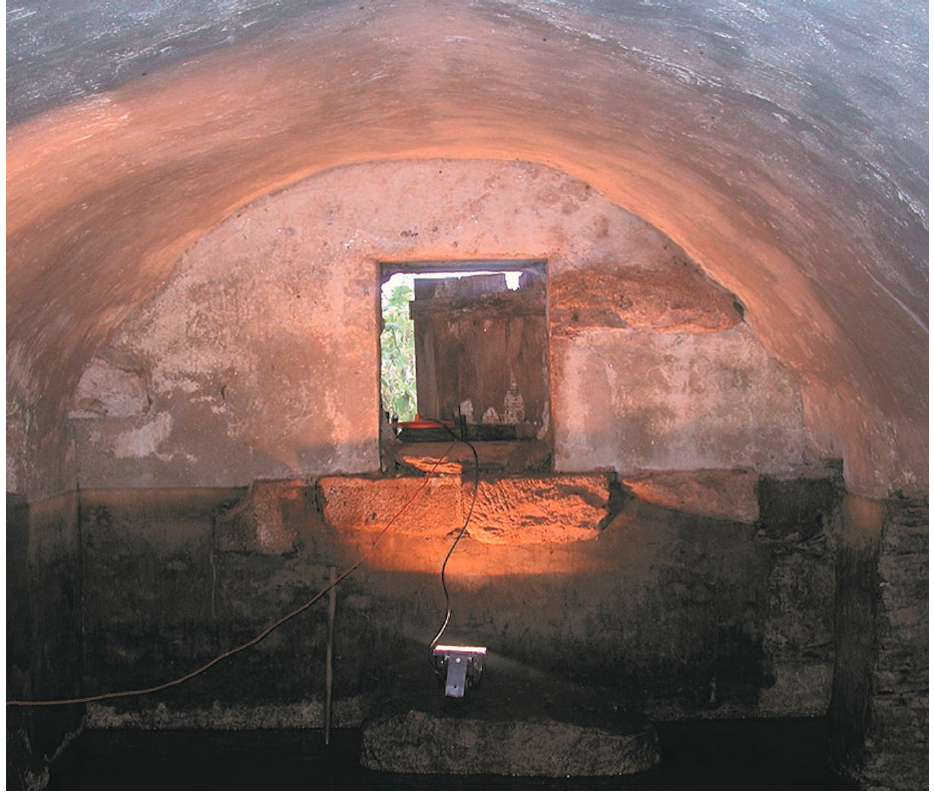
Figure 9. Deposit of Lugo’s water supply attributed to Gonzalo de la Bárcena [24]. Photgraph supplied by the authors.